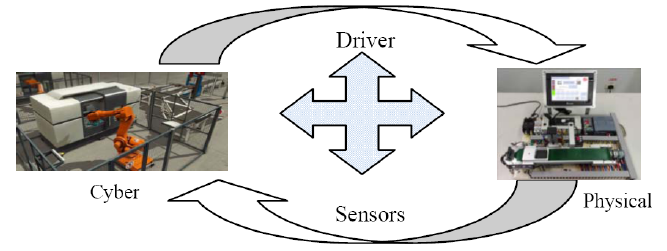
Figure 1. Operation mode of cyber-physical integration technology.